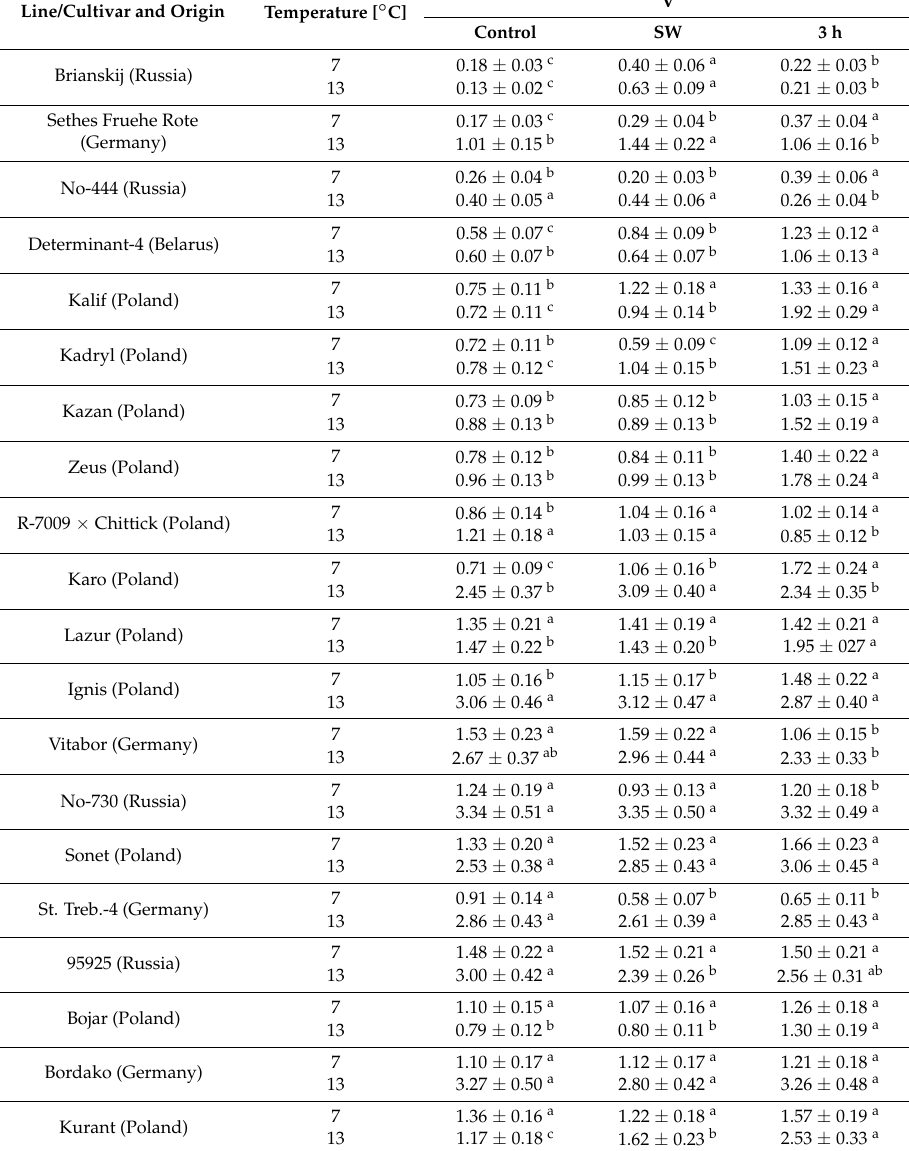
Values represent means ( n = 5) ± SE. Different superscript letters (a, b, c, ...) in the rows for each temperature indicate significant differences between means (Duncan’s multiple range test; p < 0.05). The percentage of non-germinating seeds under cold conditions, presented in Table 2, was calculated six days after